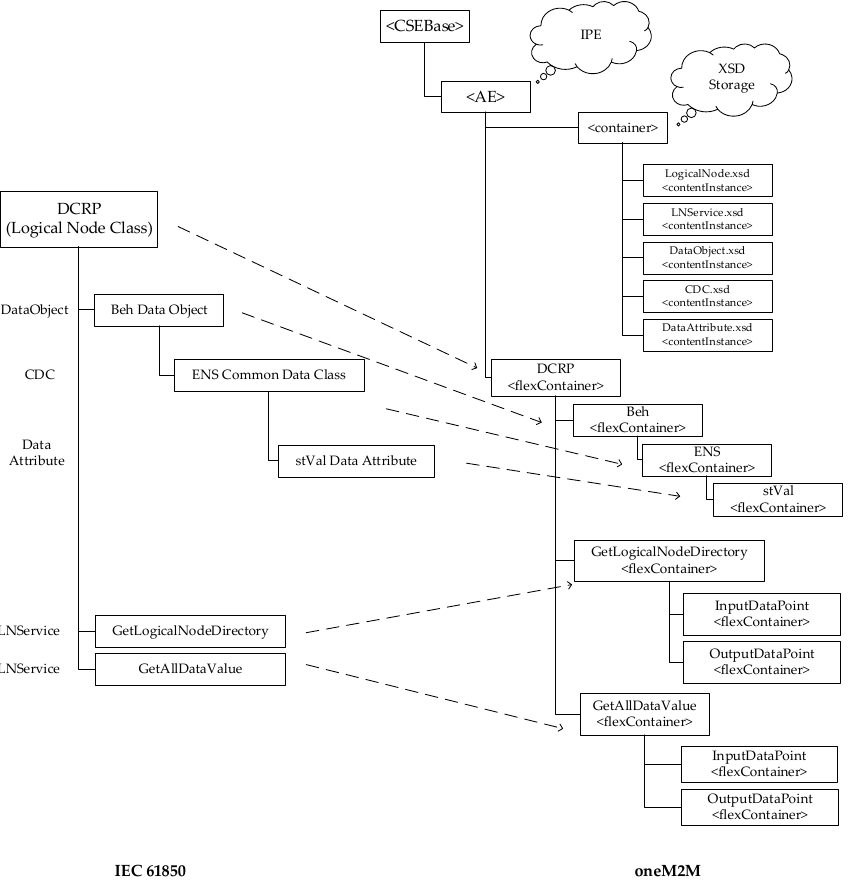
Figure 16. Example of the oneM2M resources created by IPE in the Registrar CSE at Start ‐ up.